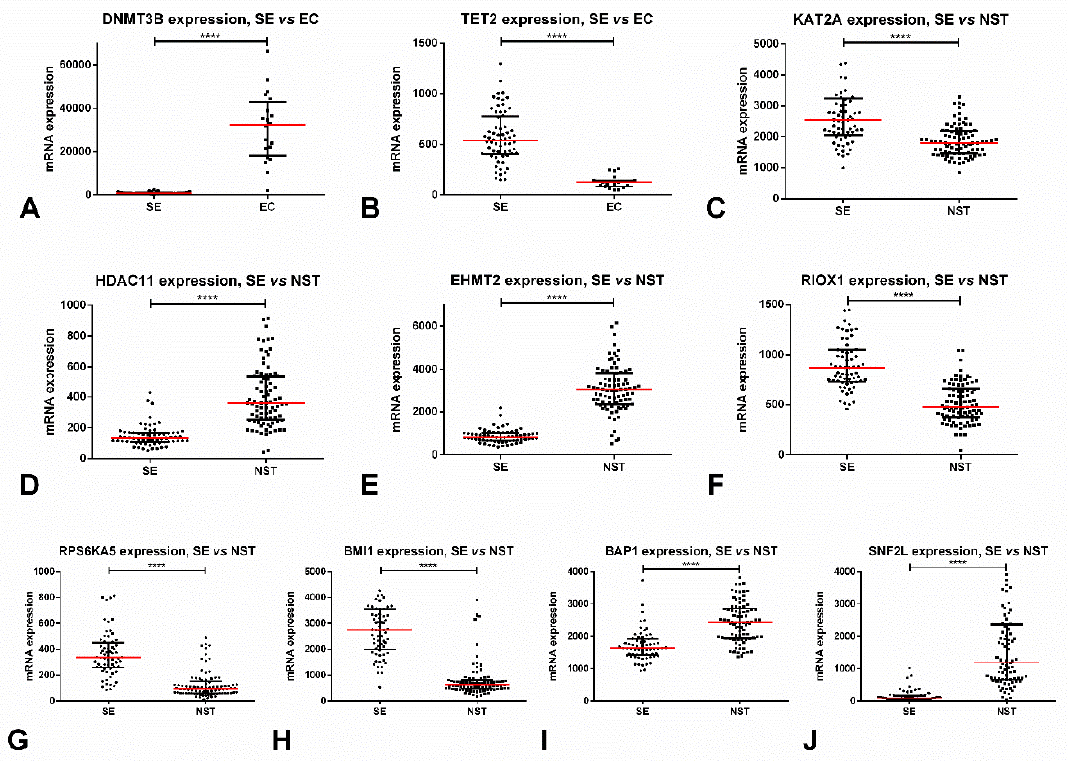
Figure 1. Most relevant alterations in protein-coding epigenetic players in testicular germ cell tumors, based on TCGA data. ( A ) Differential mRNA expression of DNMT3B among SE vs. EC; ( B ) Differential mRNA expression of TET2 among SE vs. EC; ( C ) Differential mRNA expression of KAT2A among SE vs. NST; ( D ) Differential mRNA expression of HDAC11 among SE vs. NST; ( E ) Differential mRNA expression of EHMT2 among SE vs. NST; ( F ) Differential mRNA expression of RIOX1 among SE vs. NST; ( G ) Differential mRNA expression of RPS6KA5 among SE vs. NST; ( H ) Differential mRNA expression of BMI1 among SE vs. NST; ( I ) Differential mRNA expression of BAP1 among SE vs. NST; ( J ) Differential mRNA expression of SNF2L among SE vs. NST. Abbreviations: EC—embryonal carcinoma; NST—non-seminomatous tumor; SE—seminoma; **** stands for p < 0.0001. DNA Demethylases ( TETs